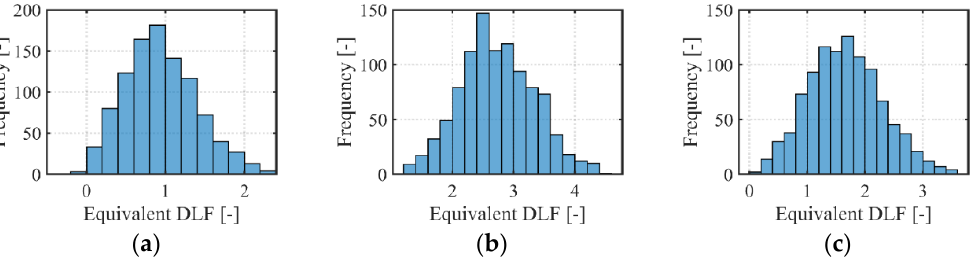
Figure 8. Equivalent DLF histogram of the first harmonic. ( a ) 1.5 Hz guidance frequency, ( b ) 2.5 Hz guidance frequency, ( c ) 3.5 Hz guidance frequency.